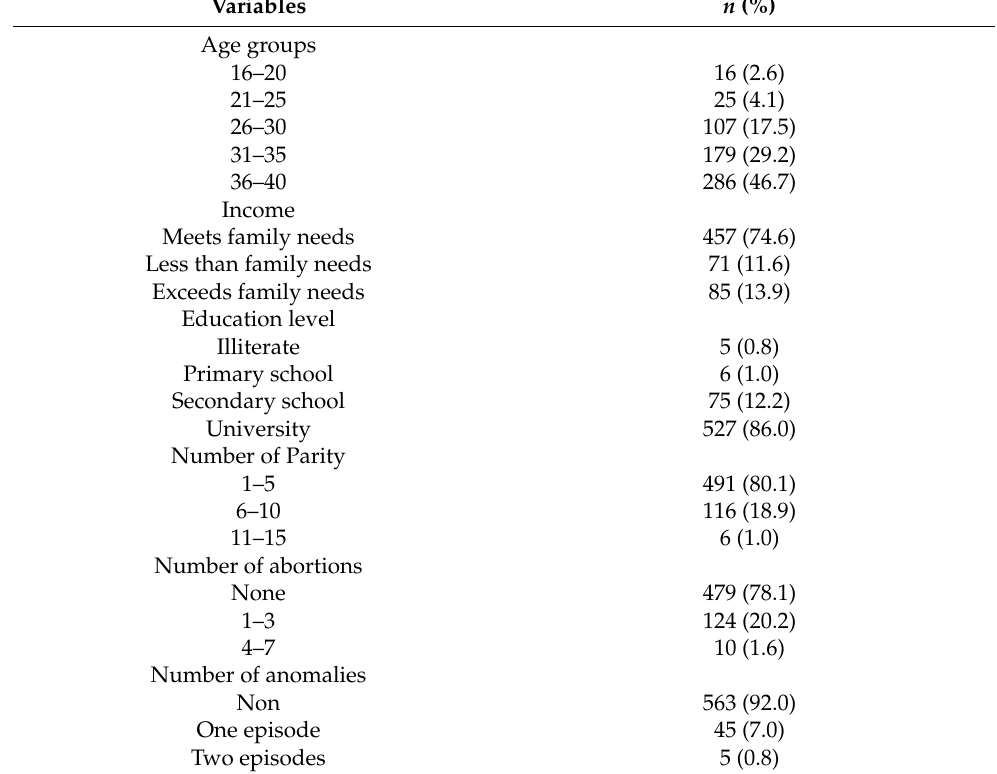
Table 1. Demographic characteristics of participants ( n = 613).